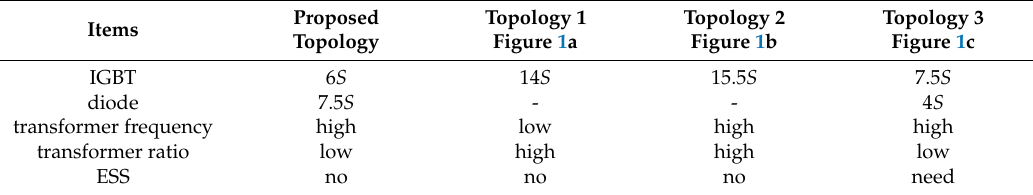
Table 1. Costs and characteristics of four